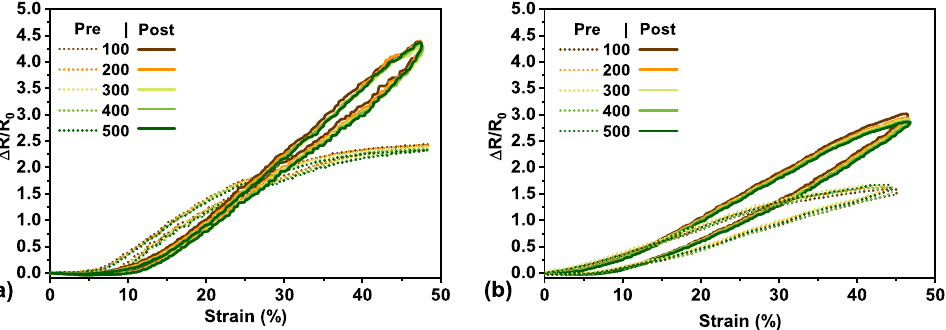
Figure 4. Cycling behavior of an unencapsulated ( a ) and encapsulated sensor ( b ), respectively, with pre-(dotted lines) and post-fracture (solid lines) represented every 100th cycle.